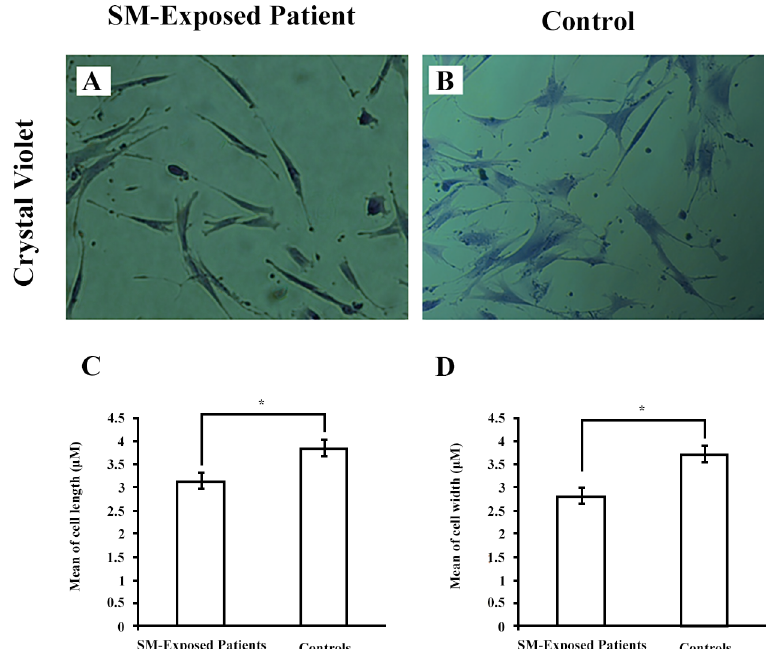
patient. The results are presented for both length (C) and width (D) as mean ± SEM for patients (n = 5) and controls (n = 4). * p < 0.05. Abbreviations: SM sulfur mustard.